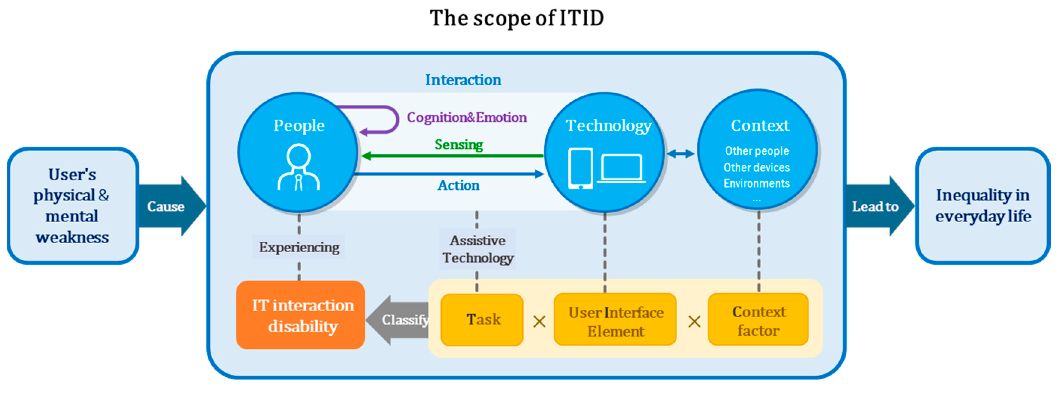
Figure 1. Depiction of the information technology interaction disability and task–interface–context framework.